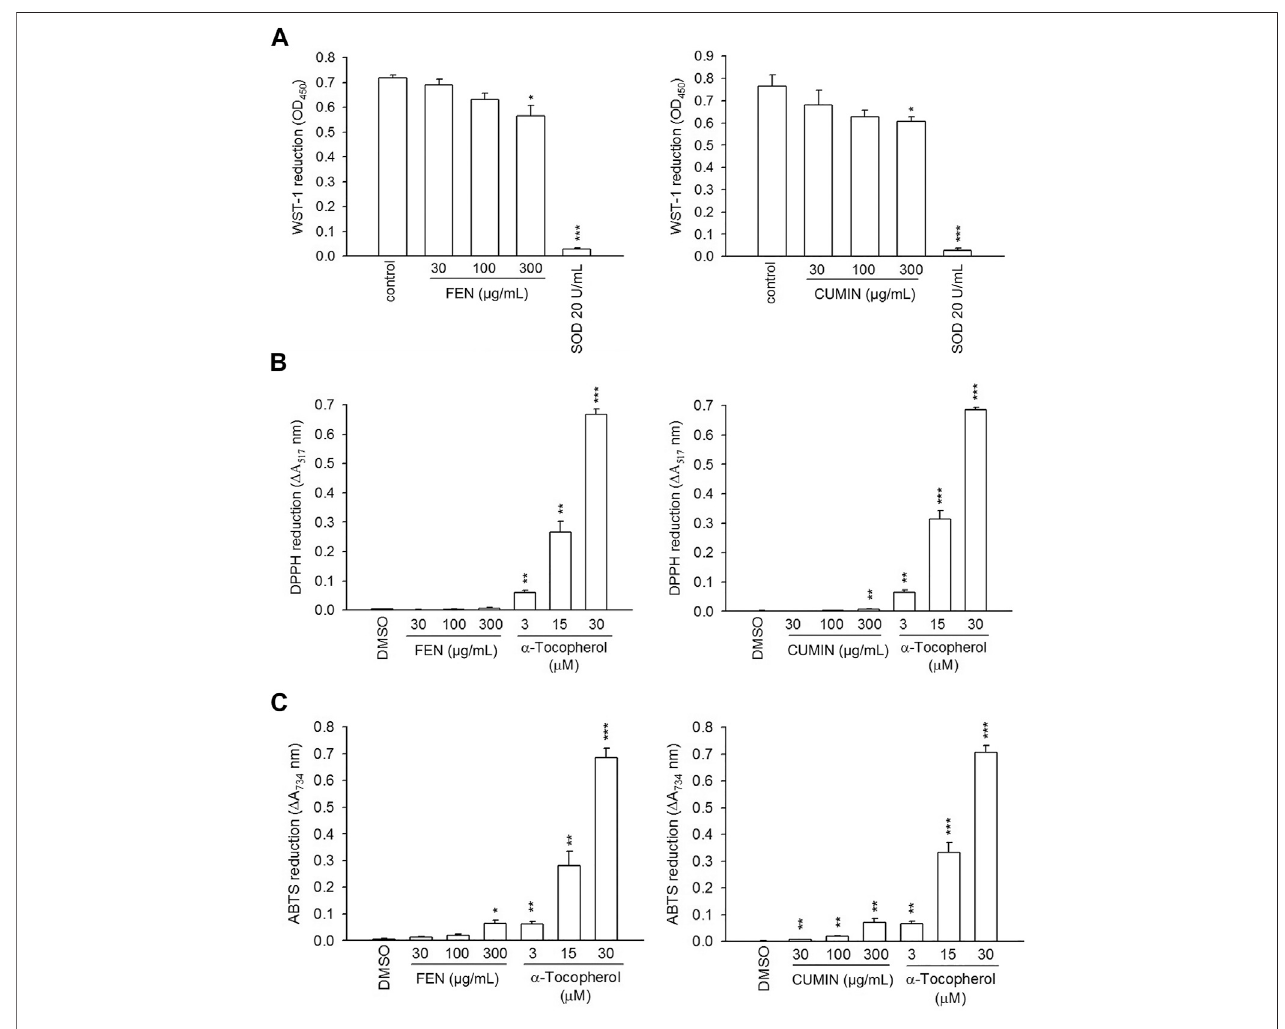
FIGURE 4 | The effects of fennel (FEN) (left panel) and cumin (CUMIN) (right panel) volatile oils on xanthine oxide and antioxidant assays in a cell-free system. Reduction of (A) WST-1, (B) DPPH, and (C) ABTS was measured at 450 nm, 517 nm, and 734 nm, respectively. SOD (WST-1) and α -tocopherol (DPPH and ABTS) were used as positive controls. Data are expressed as mean ± S.E.M. ( n (cid:2) 3). * p < 0.05; ** p < 0.01; *** p < 0.001 compared with the control (DMSO).